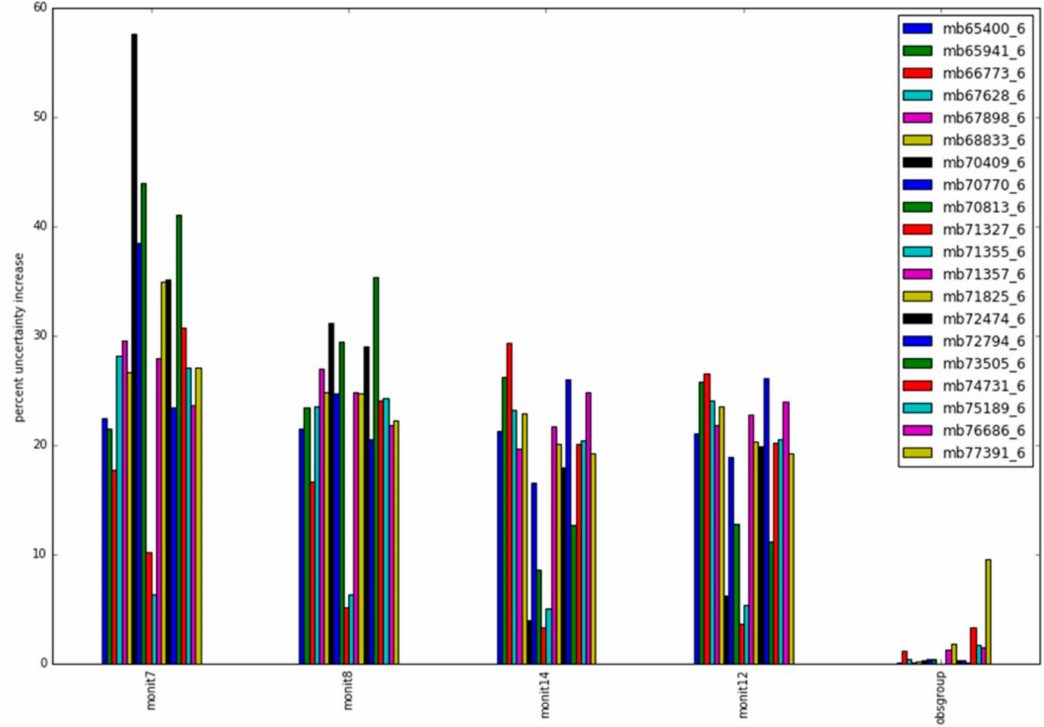
Figure 14. Relative data-worth of observation groups in informing drawdown prediction at 20 locations in model layer 6 represented as percent uncertainty increase that results when these observation groups are removed from the monitoring